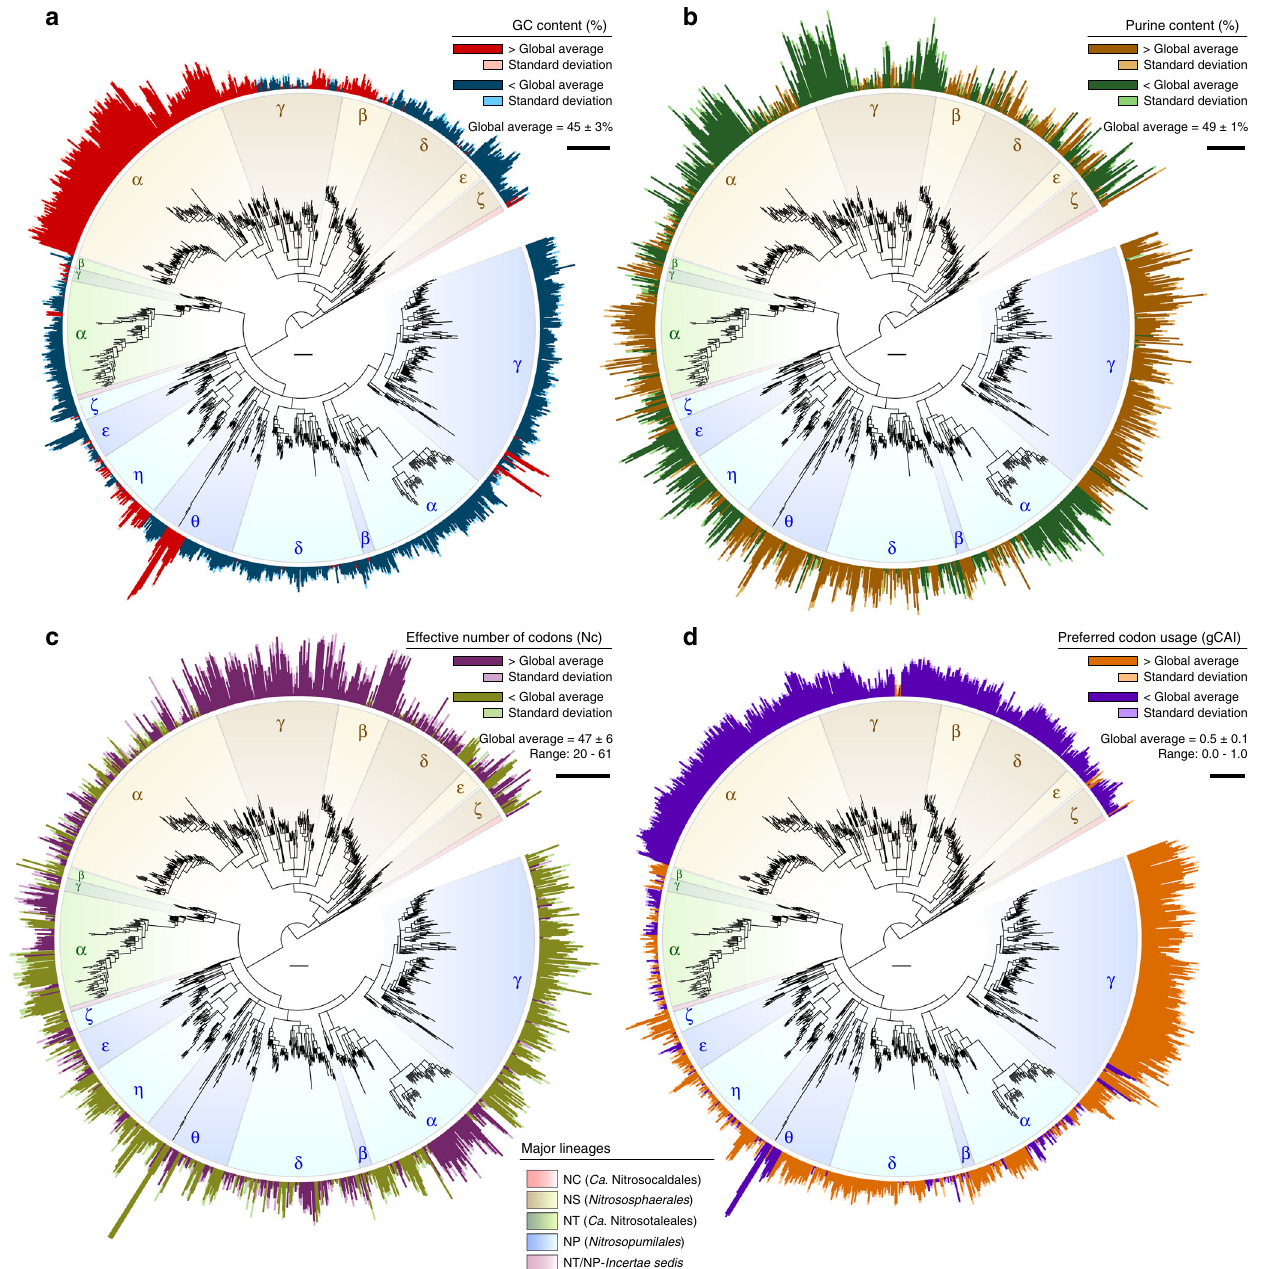
Fig. 8 Phylogenetic distribution of variation in DNA base composition and synonymous codon usage of archaeal amoA genes. a Relative GC content (%). Bars represent average GC content variation per OTU in relation to the global average: red, GC percent above average; blue, GC percent below average; the scale bar represents 5% GC. b Relative purine content (%). Bars represent average purine content variation in relation to the global average: brown, purine percent above average; green, purine percent below average; the scale bar represents 1% purine. c Relative effective number of codons (Nc) 59 . Bars represent average Nc variation in relation to the global average: violet, codon usage more relaxed than average; olive green, codon usage more biased than average; the scale bar represents 10 Nc units. d Synonymous codon usage preferences, expressed as the codon adaptation index (gCAI) 62 in relation to the overall codon bias among amoA genes; the global gCAI average represents the average deviation from the dominant codon bias. Bars represent average gCAI variation in relation to the global average gCAI: orange, codon preferences more similar to the global preferences than average; purple, codon preferences more distinct from the global preferences than average; the scale bar represents 0.1 gCAI units. Stacked bars in brighter colours represent standard deviations of the average differences in relation to the global average. Bars are drawn in proportion to the highest value according to the respective scales. Values were calculated based on all 23,395 unique sequences in the curated database. Tree scale bars represent 0.1 substitutions per nucleotide position. The phylogenetic/taxonomic distribution of molecular features is also available in an interactive Krona 47 chart in Supplementary Data 10. See legend of Fig. 1 for tree